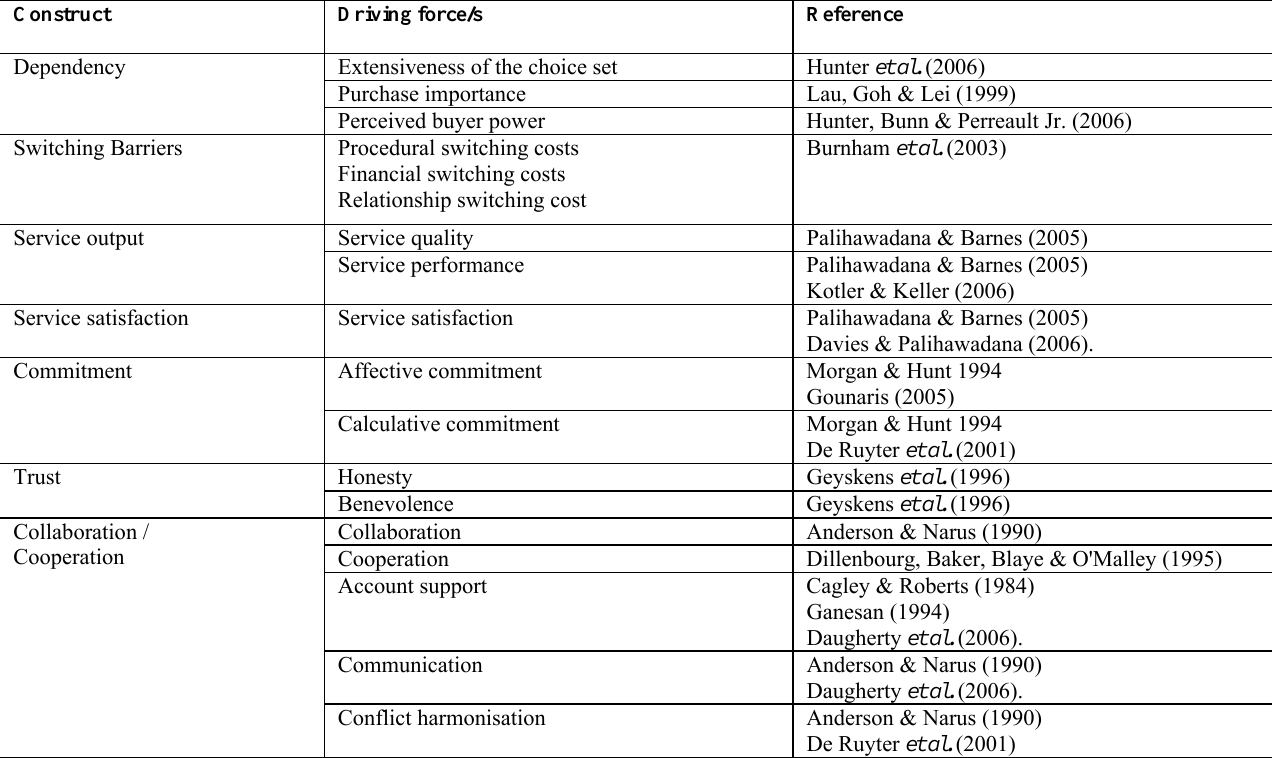
Table 1: Constructs and variables with a positive relationship with retention